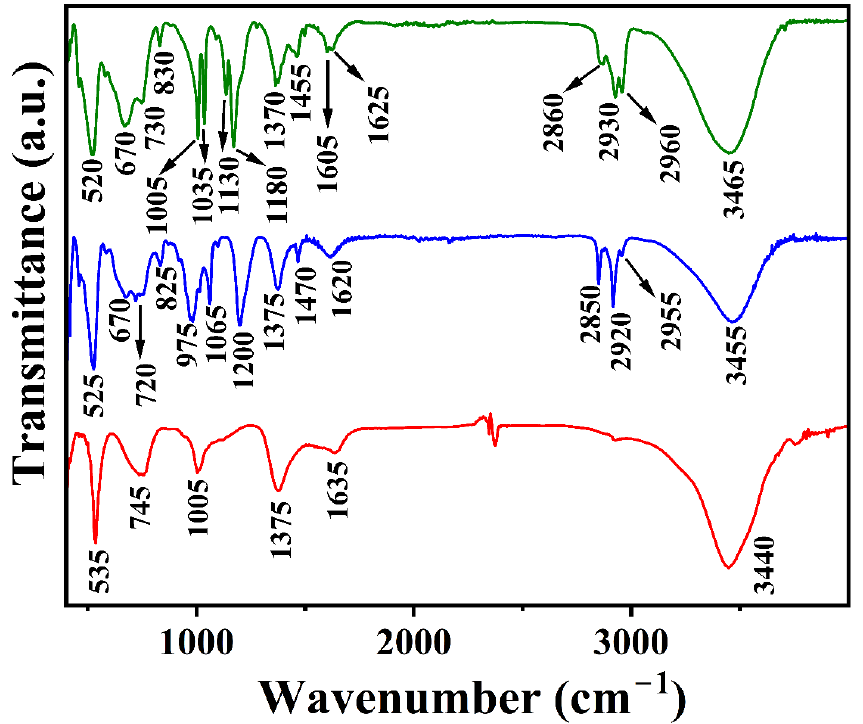
Figure 2. FTIR spectra of pristine LDH ([LiAl 2 (OH) 6 ]OH·2H 2 O) (data in red), Li-Al-DS LDH (data in blue), and Li-Al-DBS LDH (data in olive green).